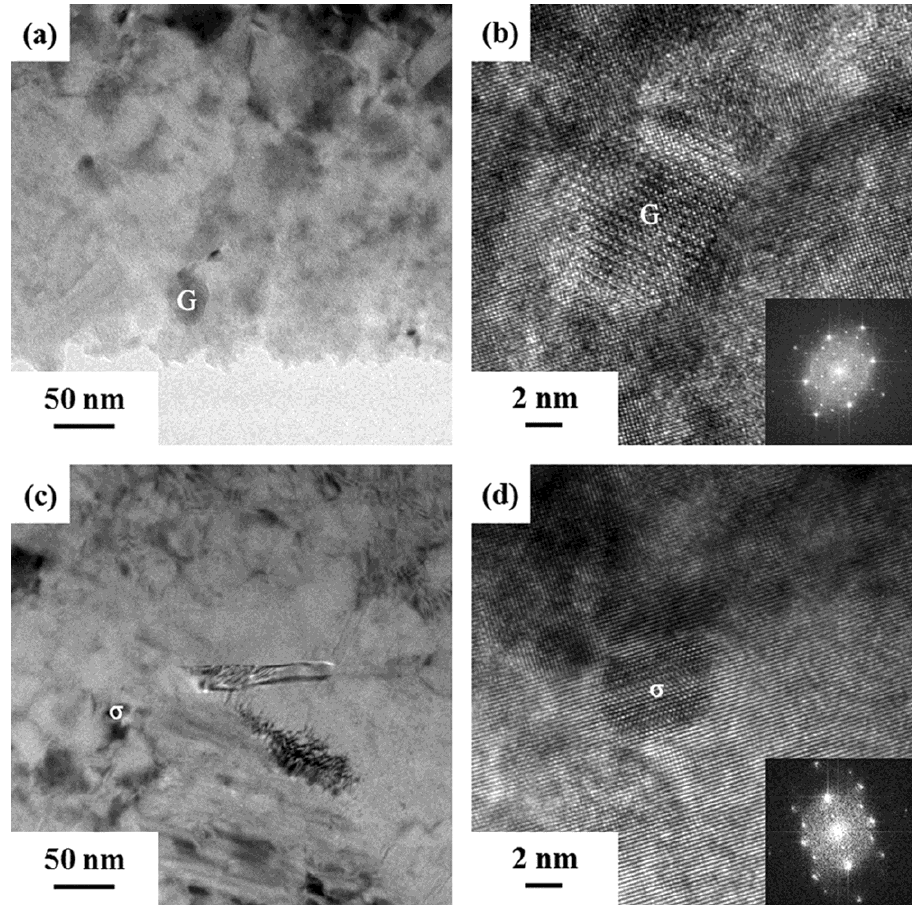
Figure 8. TEM images and high resolution lattice images with fast Fourier transform diffraction patterns of the CR-450 specimen: ( a , b ) G phase; and ( c , d ) σ phase.